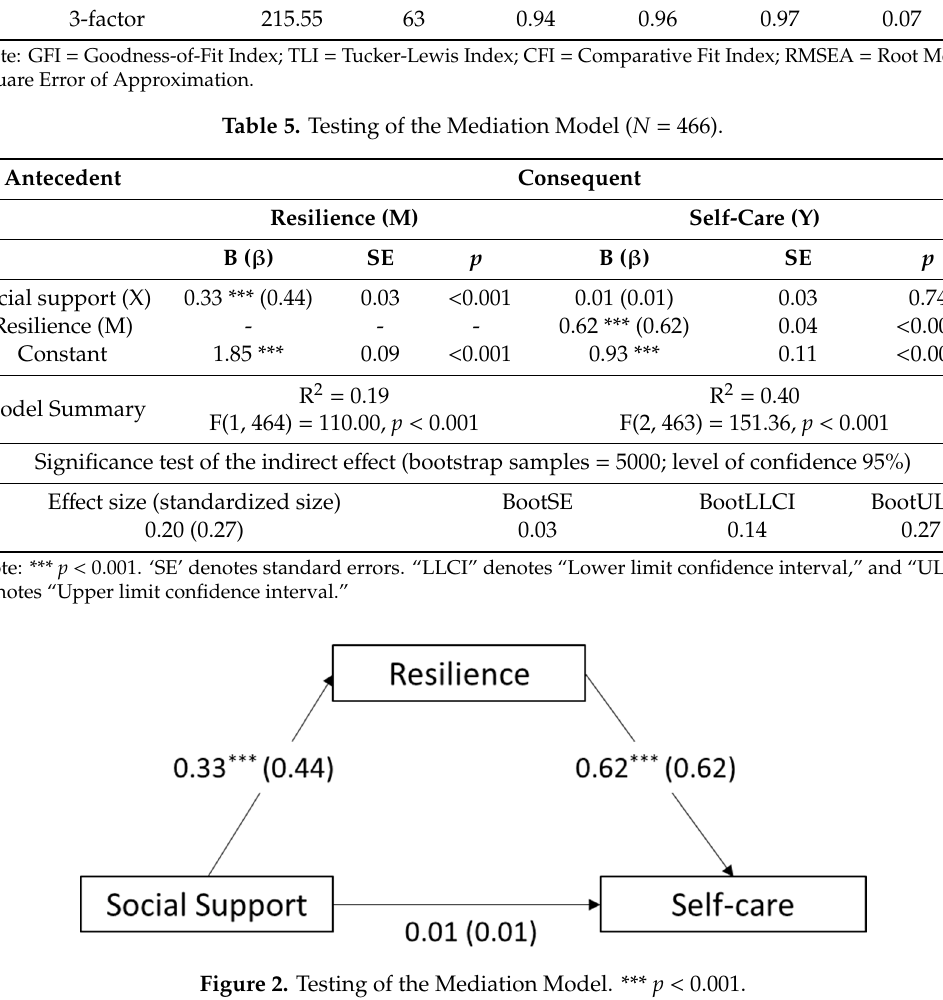
Figure 2. Testing of the Mediation Model. *** p < 0.001.